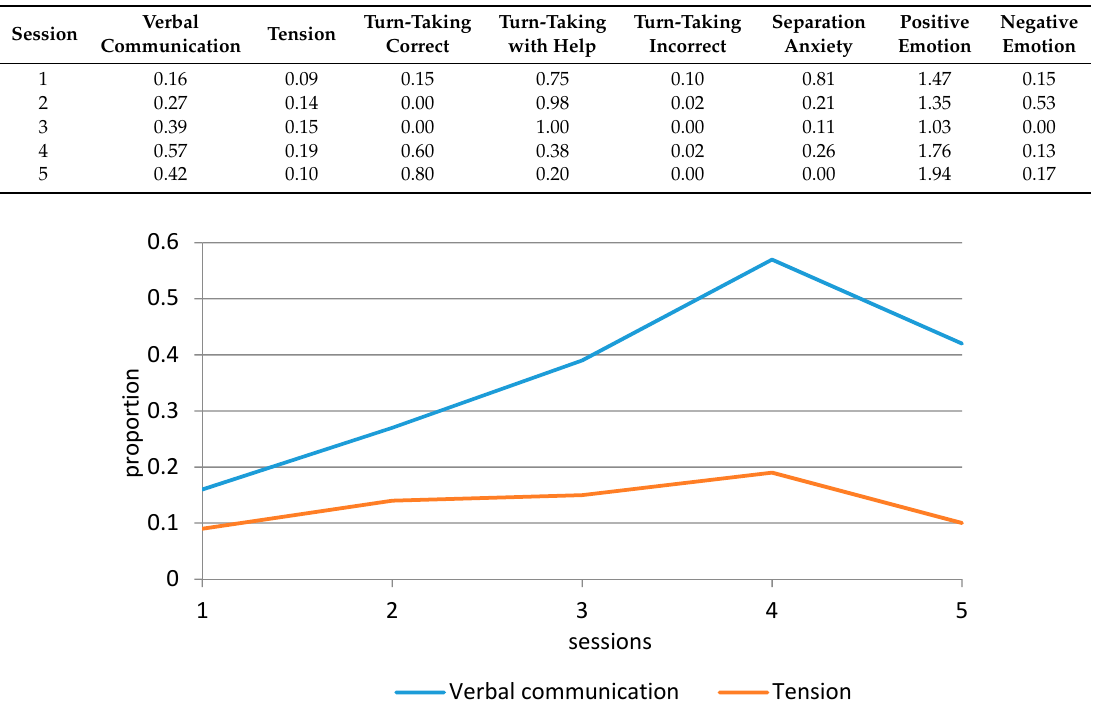
Figure 2. Graphical display of the participant’s turn-taking skills over time.